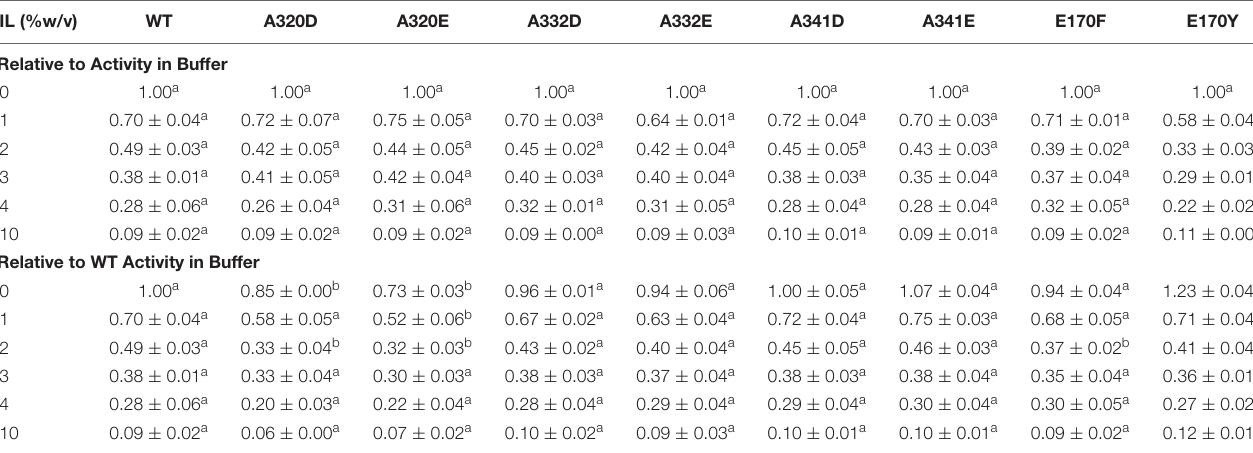
TABLE 2 | Activity of WT and mutants relative to activity in buffer in different concentrations of [C 2 C 1 Im][OAc]. IL (%w/v) WT A320D A320E A332D A332E A341D A341E E170F